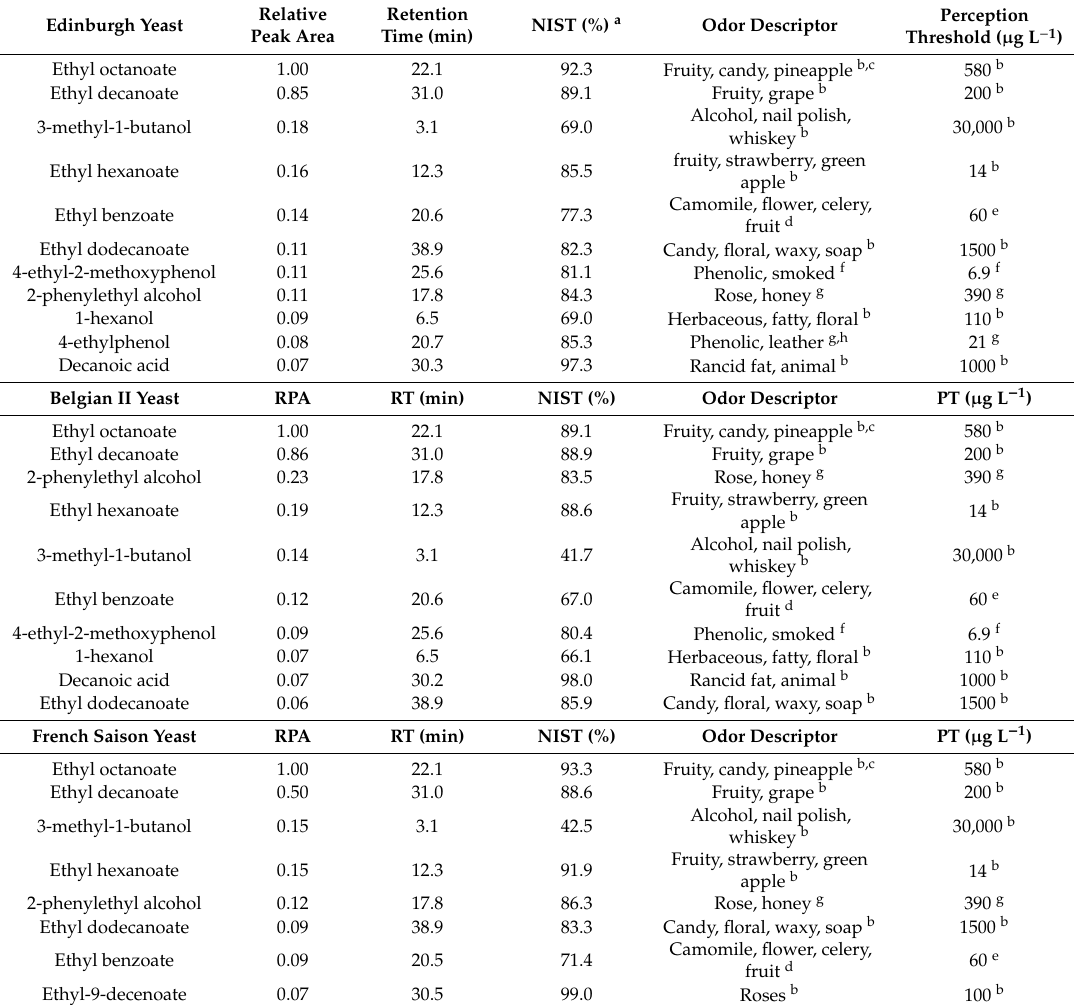
Table 1. Major ( > 0.05 relative peak area) volatile compounds identified in cider fermented (six months) with the same apple juice and di ff erent S. cerevisiae yeast strains. Retention times (RT) and perception thresholds (PT) are